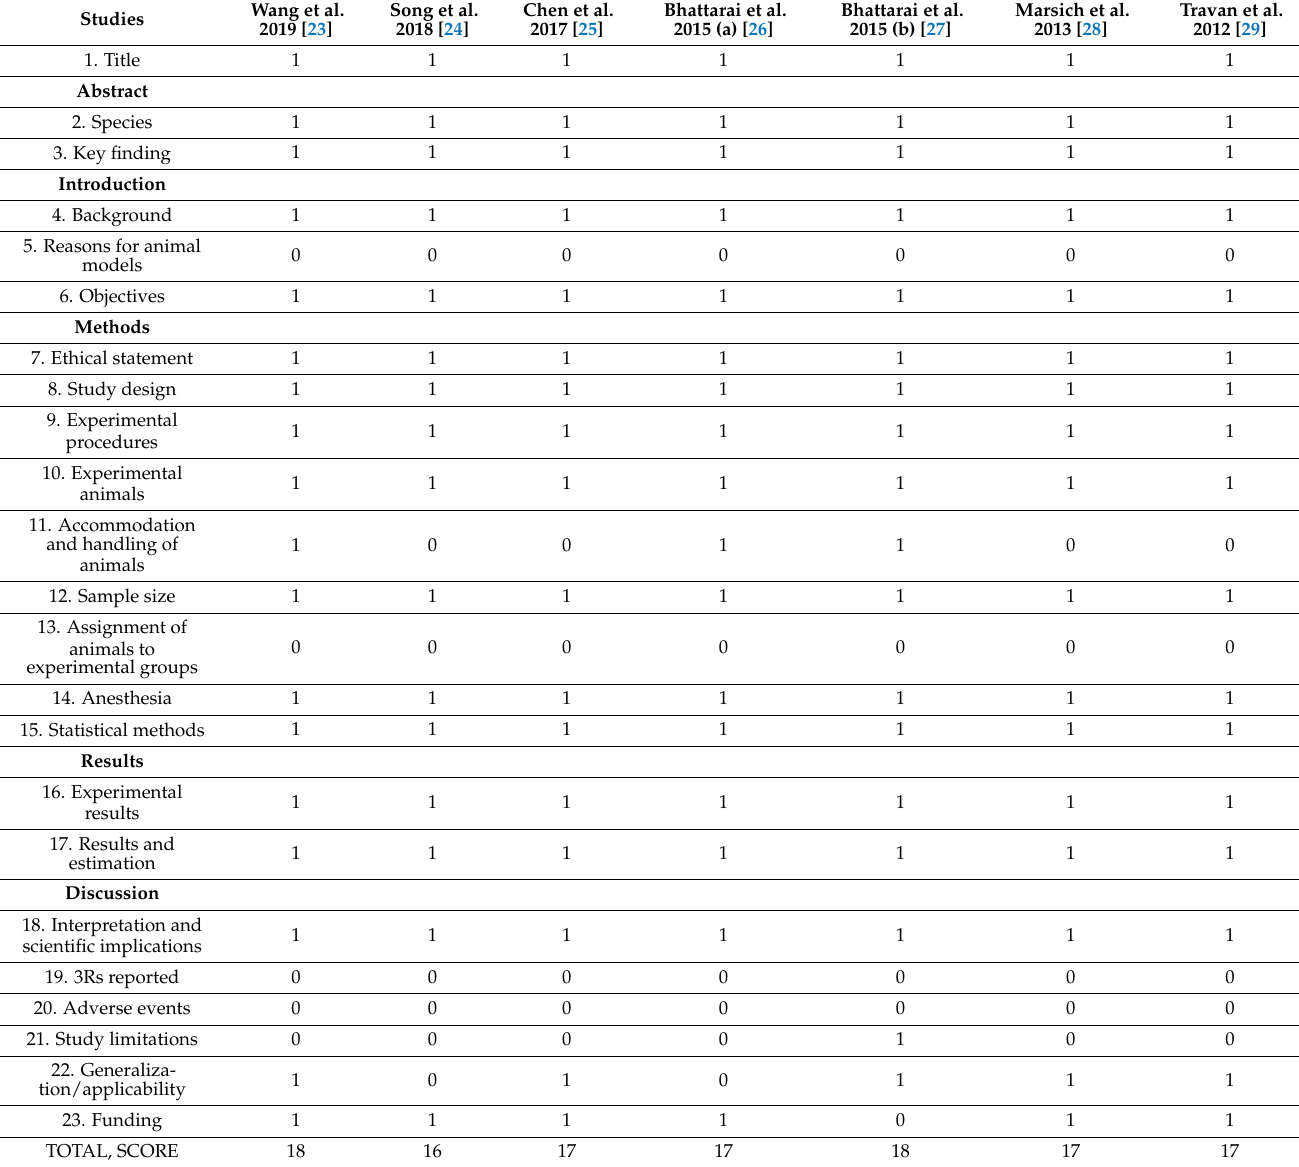
Table 1. Checklist of Animal Research: Reporting of In Vivo Experiments (ARRIVE) criteria reported by the included studies.